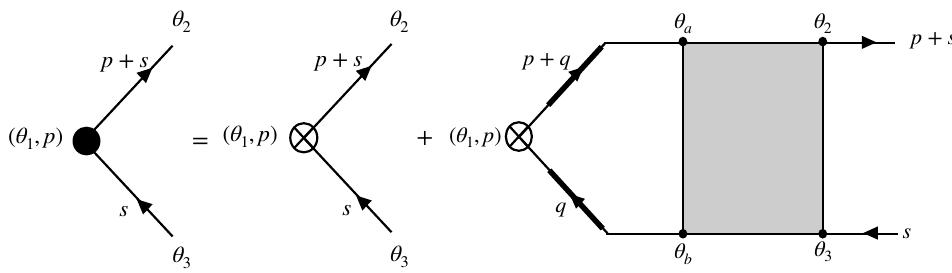
Figure 2 . Solid circle on the l.h.s. represents the full exact J 0 vertex and the (cid:12)rst diagram on r.h.s. is the free vertex. The second diagram on r.h.s. includes all the interactions which are accounted by insertion of exact 4 point vertex (3.3) connected to the external J (0) operator using the exact